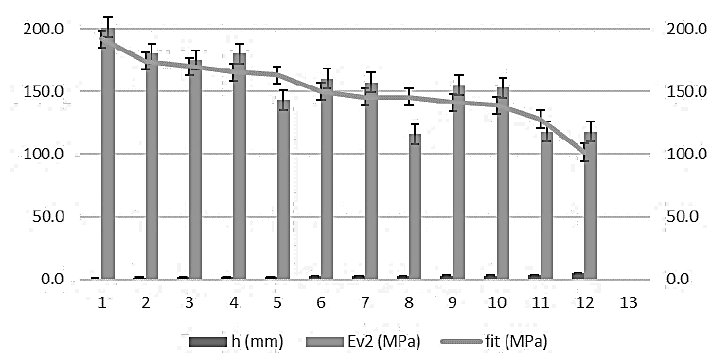
Figure 8. Error bars for wheel-tracking test and second modulus of PLT ( Φ 600mm).